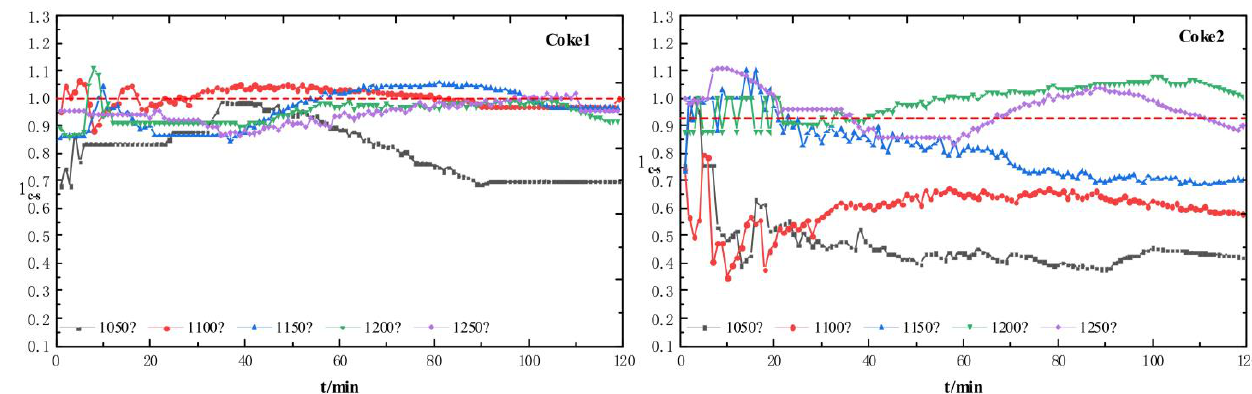
Figure 9. Coupling factor curves of coke and sinter. Table 7. Influencing factors of average weight loss rate in reaction time at each temperature point, %.